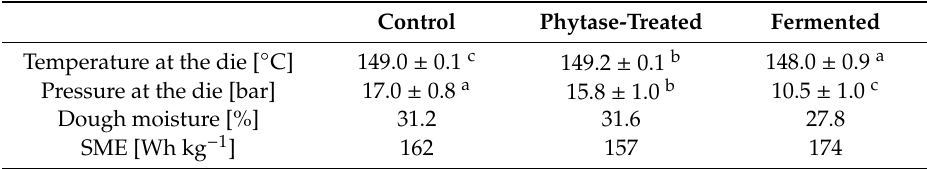
Table 3. Actual measured extrusion parameters. Standard deviations are shown ( n = 180). Values sharing a letter within a row are not statistically different. SME: specific mechanical energy.